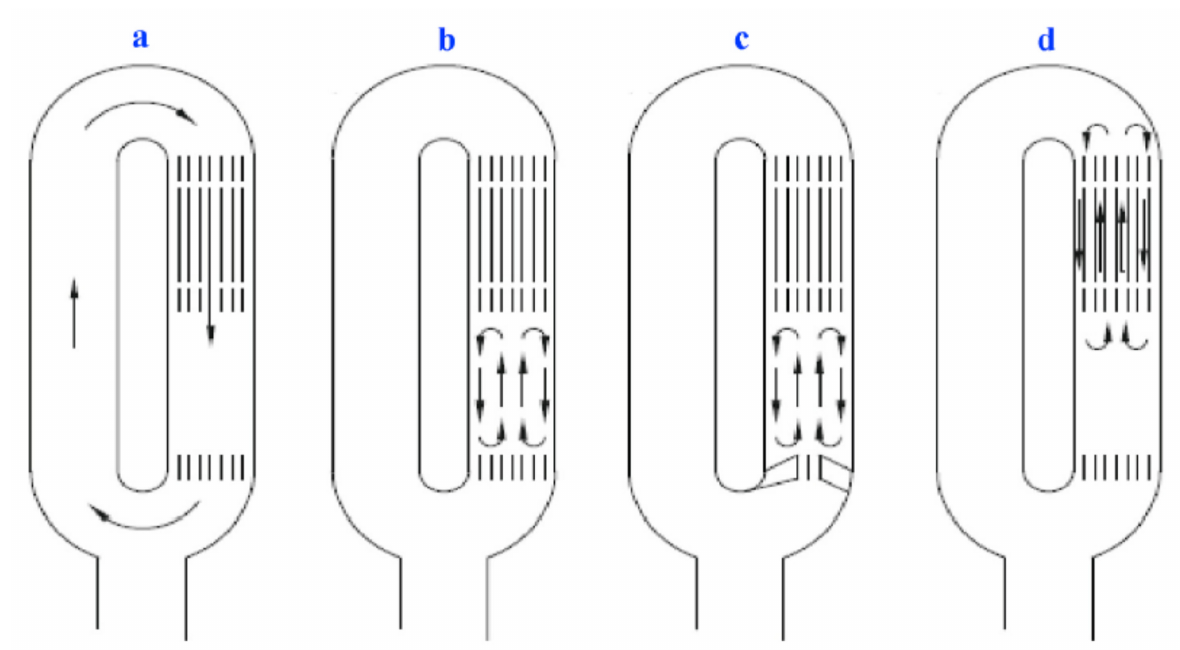
Figure 7. ( a ) Gedeon streaming, ( b ) Rayleigh streaming, ( c ) jet-driven streaming and ( d ) streaming with a regenerator or stack